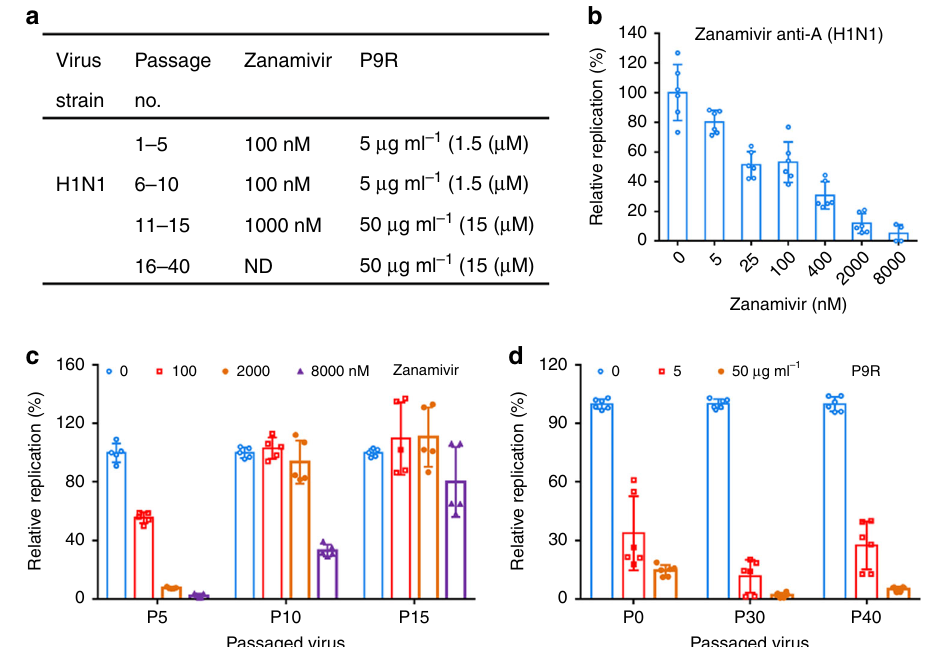
Fig. 5 P9R showed low possibility to cause drug-resistance virus. a The procedure of drug-resistance assay for zanamivir and P9R. A(H1N1) virus was passaged in the presence of indicated concentrations of zanamivir or P9R. ND, not detected because the high resistant H1N1 virus against zanamivir was generated before P16. b Zanamivir inhibited parent A(H1N1) virus (P0). The IC 50 of zanamivir against parent H1N1 was 35 nM. Data are presented as mean ± SD of three independent experiments. c The antiviral ef fi ciency of zanamivir against passaged A(H1N1) virus in the presence of zanamivir ( n = 5). d The antiviral ef fi ciency of P9R against passaged A(H1N1) virus in the presence of P9R ( n = 6). Passaged viruses were premixed with zanamivir (nM) or P9R ( μ g ml − 1 ) for infection. Supernatants were collected at 24h post infection. Viral titers in the supernatants were determined by RT-qPCR. The relative replication (%) was normalized to the corresponding passaged viruses without treatment. Data are presented as mean ± SD of at least three independent experiments. Source data are provided as a Source data fi